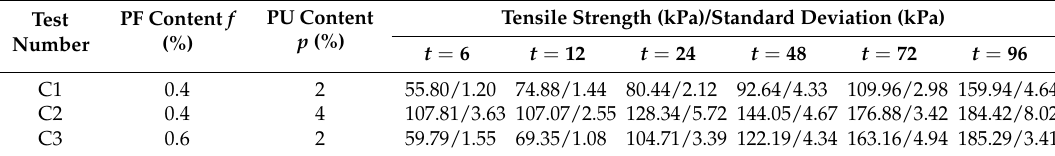
Table 6. Tensile strength of C1–C3